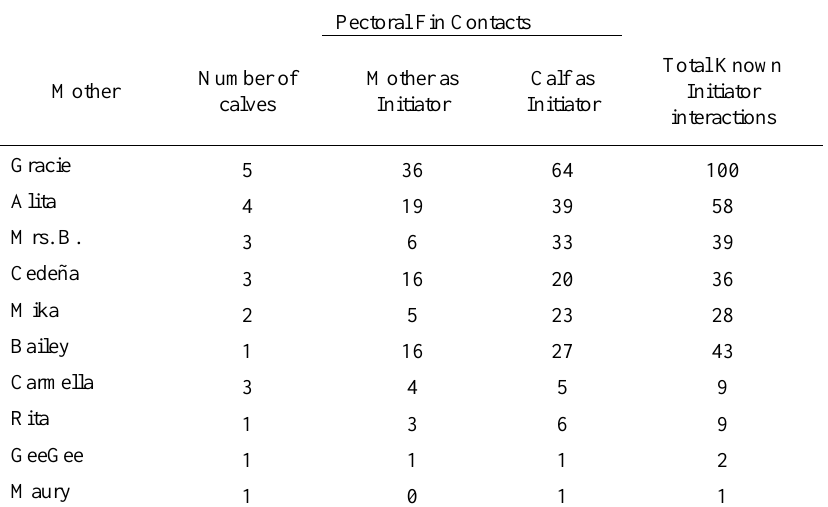
Total Number of PFC for Adult Females with her Calves, Regardless of Calf Sex and Age, Categorized by the Mother as Initiator and Mother as Receiver (i.e., Calf as